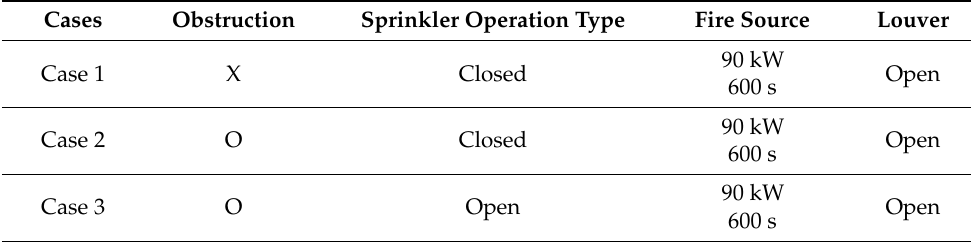
Figure 1. Geometry of the enclosure room fire, ( a ) sprinkler: sprinklers are installed 20 and 50 cm under the ceiling, ( b ) fire source, ( c ) louver, ( d ) open boundary, ( e ) obstruction. Table 1. Summary of numerical